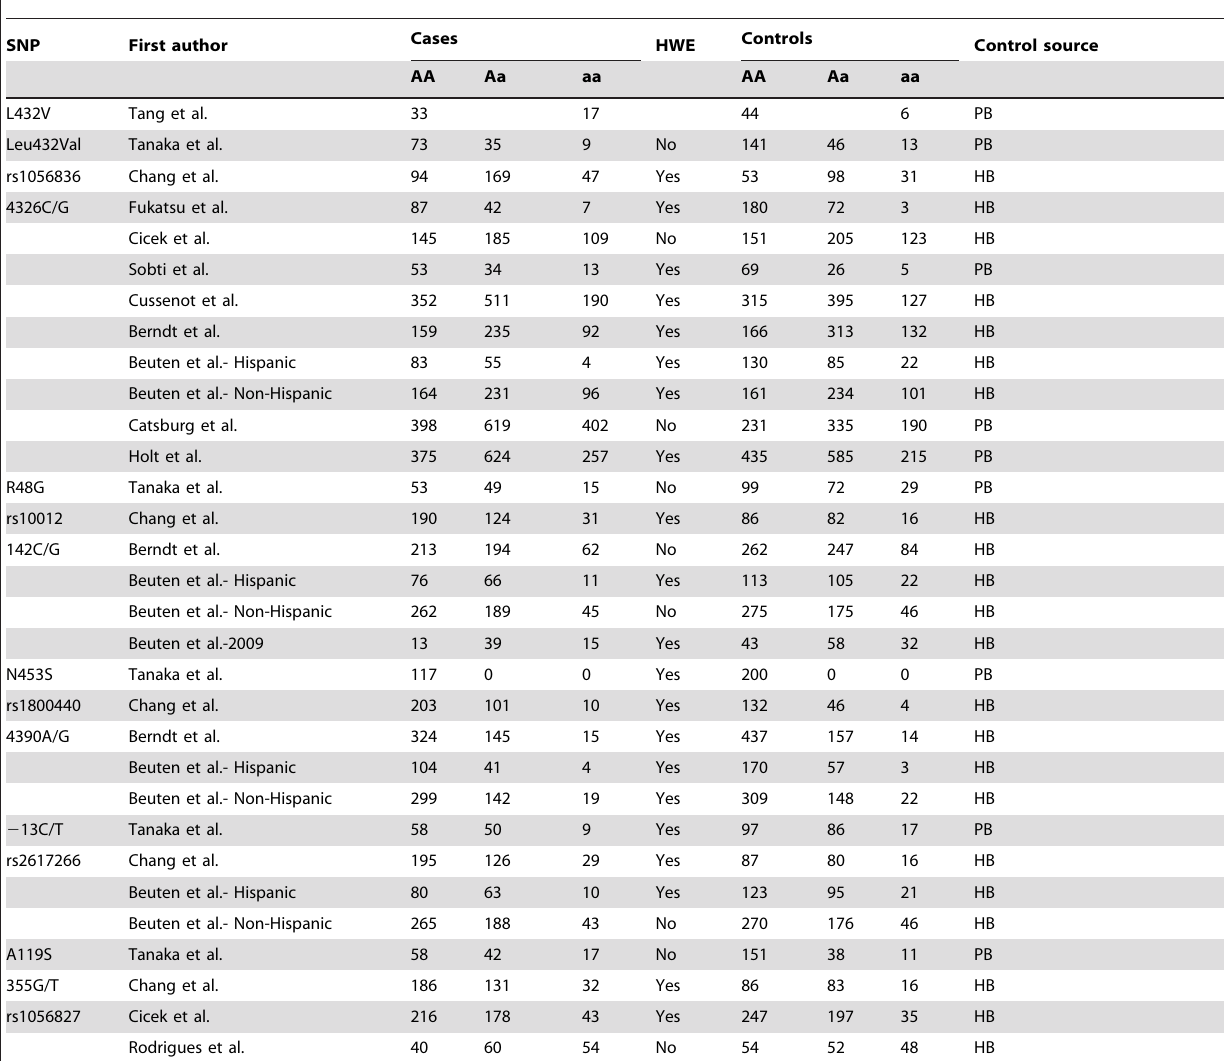
Table 2. Distribution of CYP1B1 genotype among prostate cancer cases and controls included in the meta-analysis.